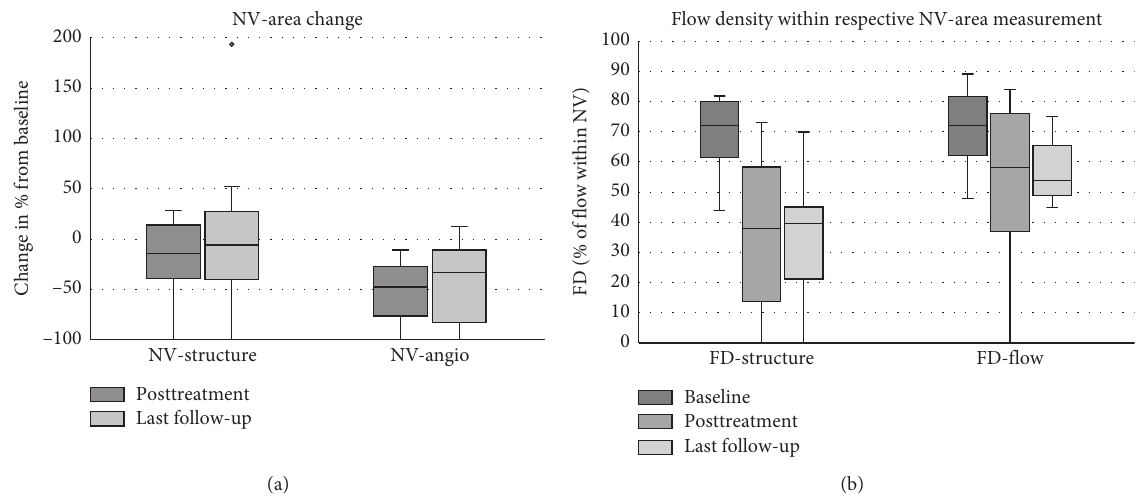
Figure 2: (a) Changes of neovascularization- (NV-) size measurements relative to baseline after the initial treatment block of three to four intravitreal anti-VEGF injections, and at the last follow-up. En face structural area (NV-structure) decreased by median 15% (range − 28%– 100%) and remained decreased by median 6% ( − 196%–100%). En face flow area (NV-angio) decreased by median 48% (range 10–100%) and remained by median 34% less than baseline ( − 13%–100%). The graph shows the reduction of NV size is more prominent in the angio than the structural en face OCTA image. (b) En face flow density (FD) measurements within the structural neovascularization (NV-area (FD- structure) and the flow NV-area (FD-angio)) at baseline, after the initial treatment block of three to four intravitreal anti-VEGF injections, and at the last follow-up: FD-structure started at median 64% (range 41–82%), decreased to median 32% (0–73%), and remained at median 32% (0–70%). FD-angio started at median 71% (range 48–89%), decreased to median 51% (0–84%), and remained at median 54% (0–75%). The graph shows that the difference in flow density between baseline, after treatment, and with apparently quiescent diabetic retinal neovascularization is more pronounced within the structural than the angio area of a